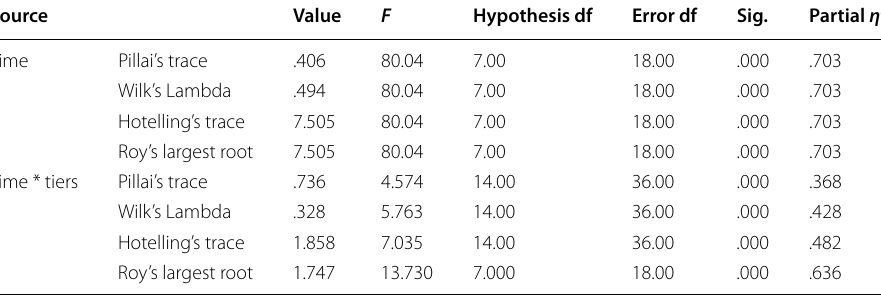
Table 7 Multivariate tests of within-subjects effect in individual group Source Value F Hypothesis df Error df Sig. Partial η 2